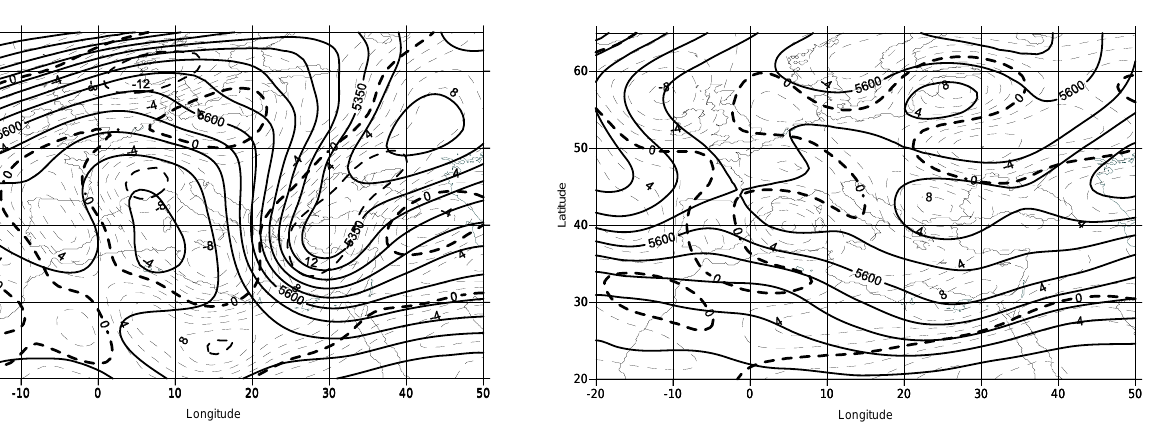
Fig. 5. The divergence of the horizontal wind vector over the 850hPa isobaric surface (×10 -6 s - 1 ) for the cluster “North”, at time D0.